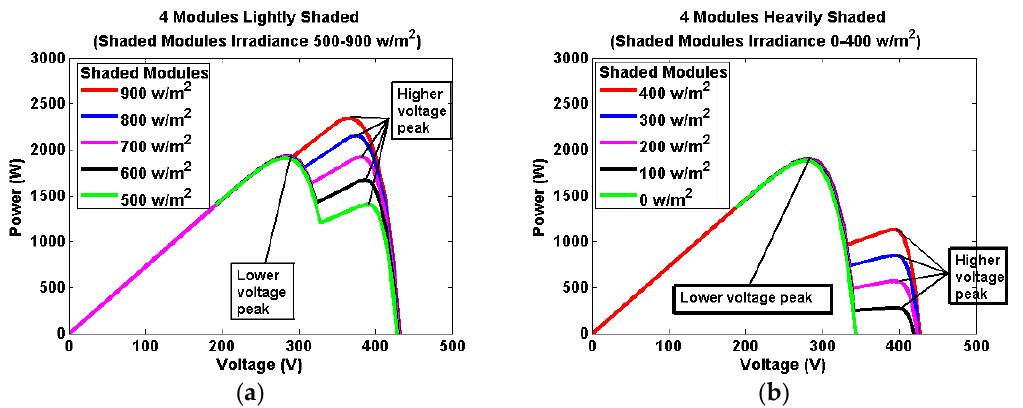
Figure 8. P-V characteristics of the 4 modules shaded setups: ( a ) shaded modules irradiance is between 500 and 900 w/m 2 ; ( b ) shaded modules irradiance is between 0 and 400 w/m 2 .